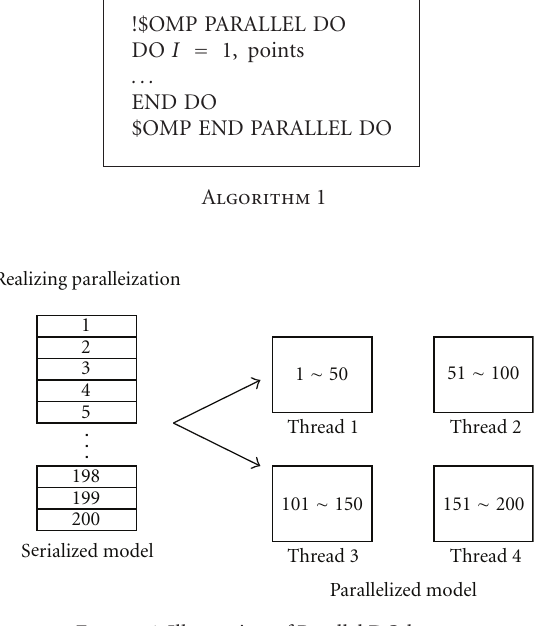
Figure 6: Illustration of Parallel DO loop.